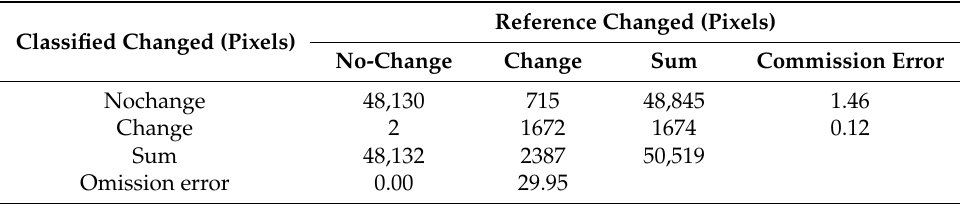
Table 2. Confusion matrix of change/no-change detection